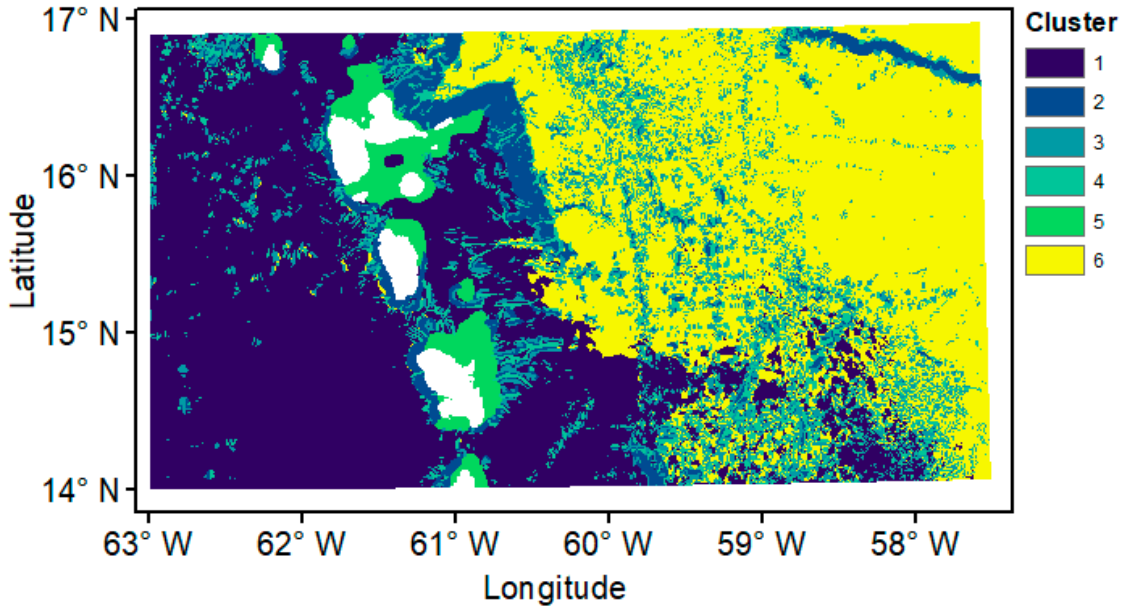
Figure 3. Broadscale Landscape Map for the larger study area, using three eigenvalues. Showing the K-means cluster analysis results of the six cluster classes.